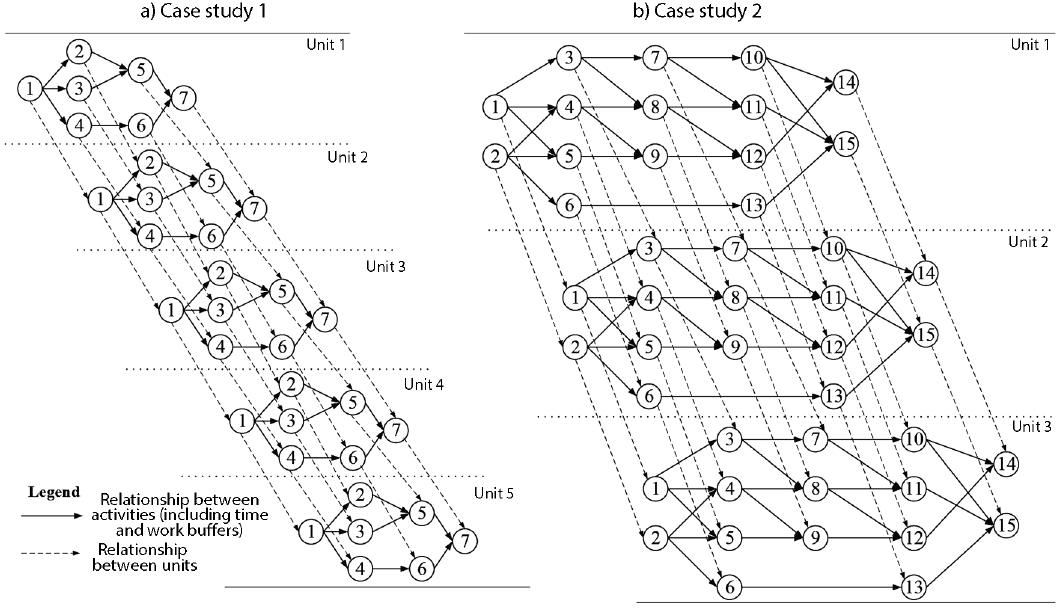
Figure 6. Network of